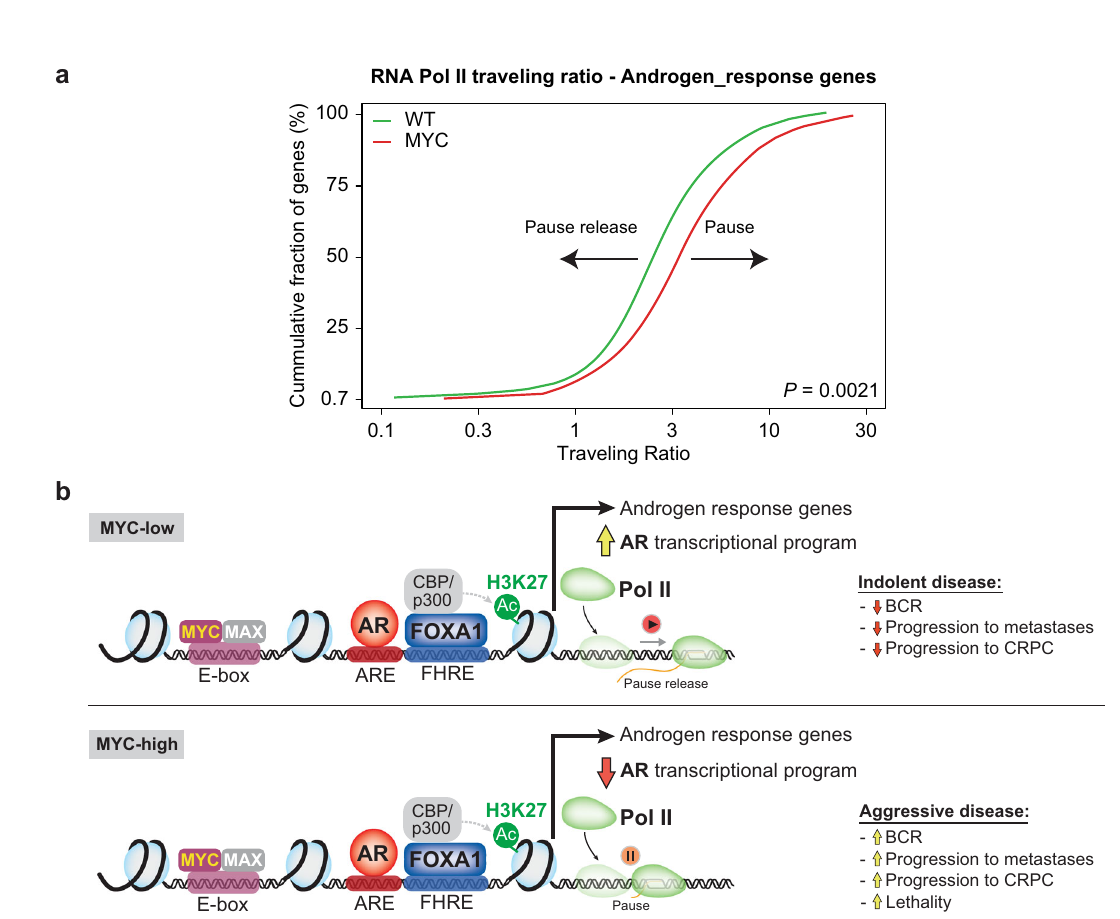
Fig. 7 MYC overexpression disrupts the AR transcriptional program by pausing AR regulated genes. a BETA analysis revealed that AR binding sites are associated with gene downregulation following MYC overexpression. b , c Despite a dampened AR transcriptional program, higher levels of the AR binding